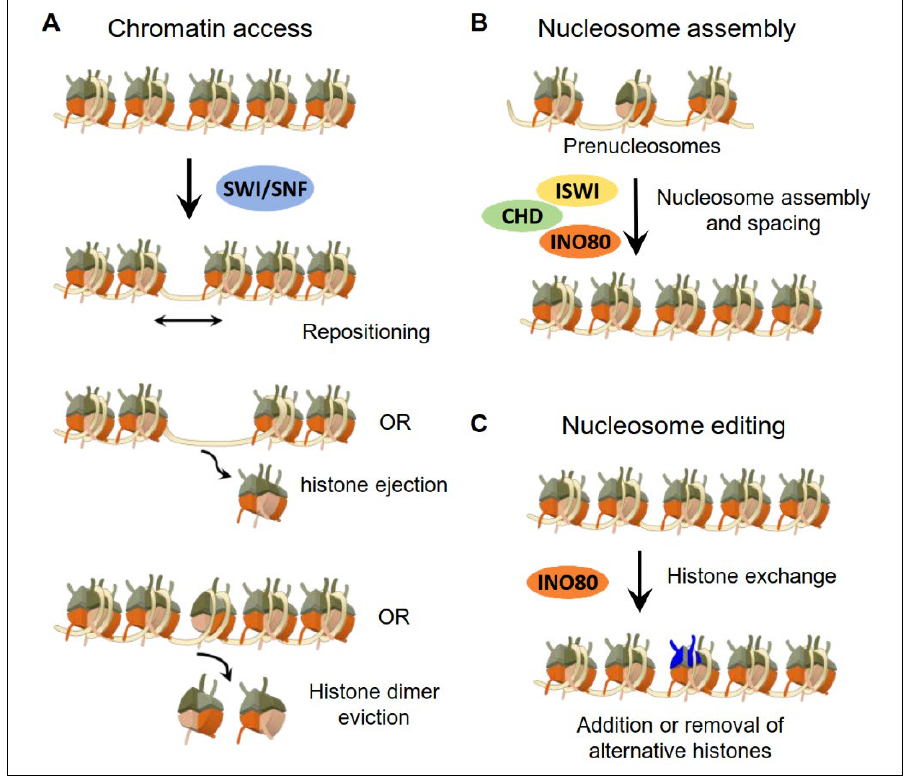
Figure 2. Brief classification of the functions of chromatin remodelers. ( A ) Chromatin access: Primarily SWI/SNF subfamily remodelers restructure chromatin coupling ATP hydrolysis via repositioning nucleosomes, ejecting histone octamers or evicting nucleosomes histone dimers. ( B ) Nucleosome assembly: In particular, ISWI, INO80 and CHD subfamily remodelers re-establish chromatin architecture by the random deposition of histones, the physiological spacing of nucleosomes, and the maturation of nucleosomes. ( C ) Nucleosome editing: INO80 subfamily remodelers alter nucleosome composition via canonical and variant histone exchange, such as histone variants, as marked in blue.